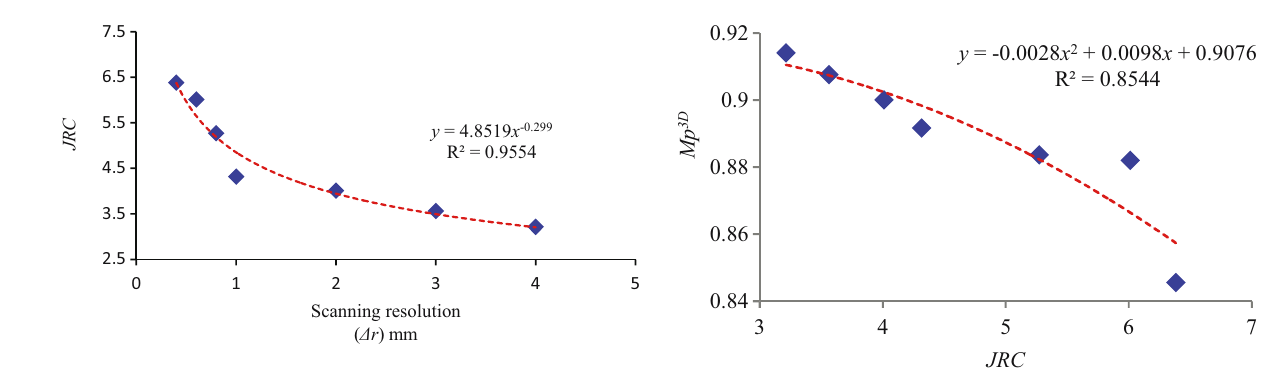
Figure 11: Relation curve of JRC with di ff erent resolutions.